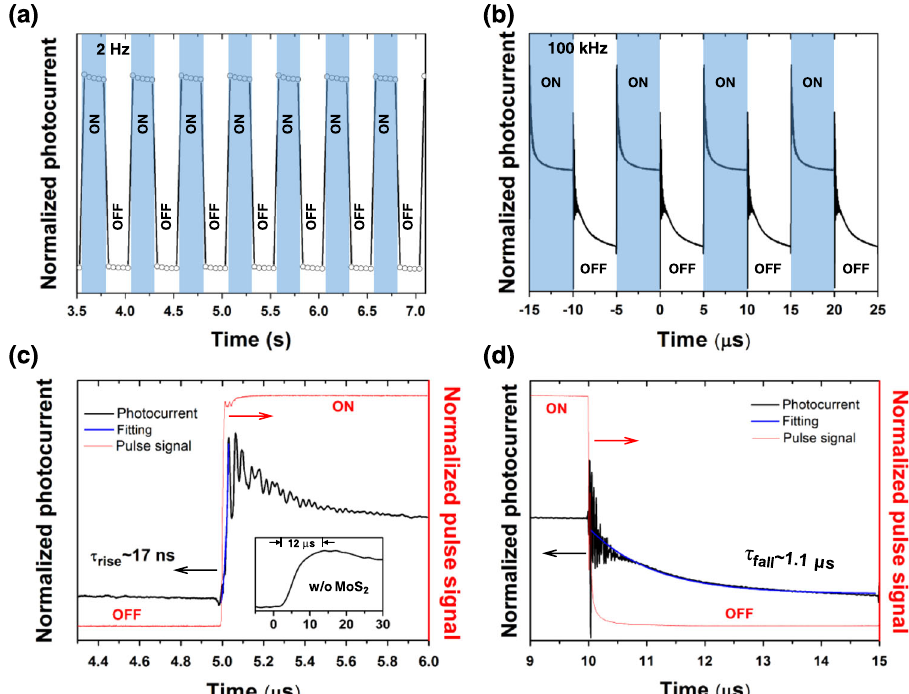
Fig. 3 The temporal performance of the hybrid graphene photoconductor. Switching characteristics of the device under a 2 Hz and b 100 kHz square-wave light pulse (635 nm). Enlarged views of ( b ) at light being switched on ( c ) and light being switched off ( d ). Inset in ( c ): rising edge of the device without MoS 2 layer